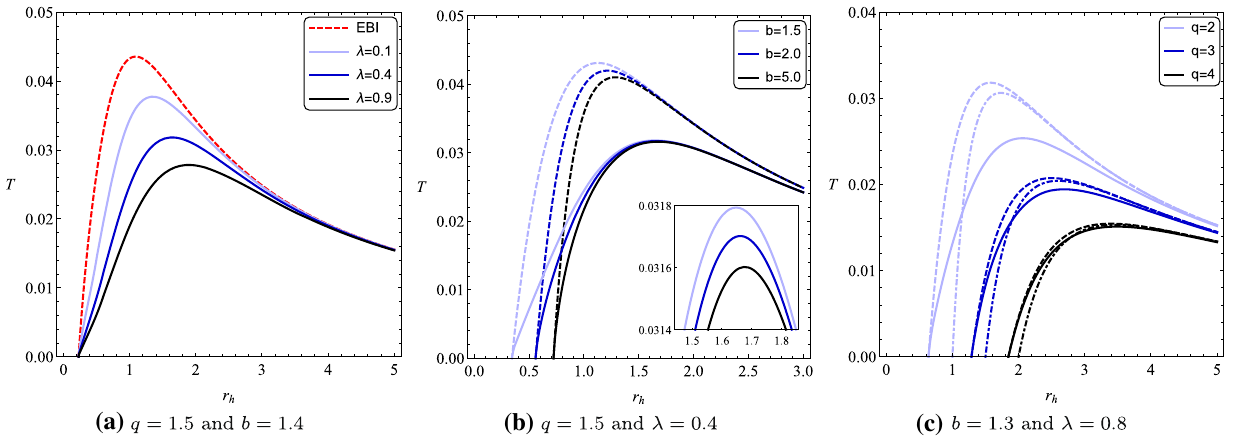
Fig. 1 The behavior of T versus r h for spherical asymptotically flat solutions with various values of λ , b and q . Note that the solid (dashed) curves show the temperature in the presence (absence) of cubic terms. In the right panel, dot-dashed curves show the temperature for Einstein–Maxwell